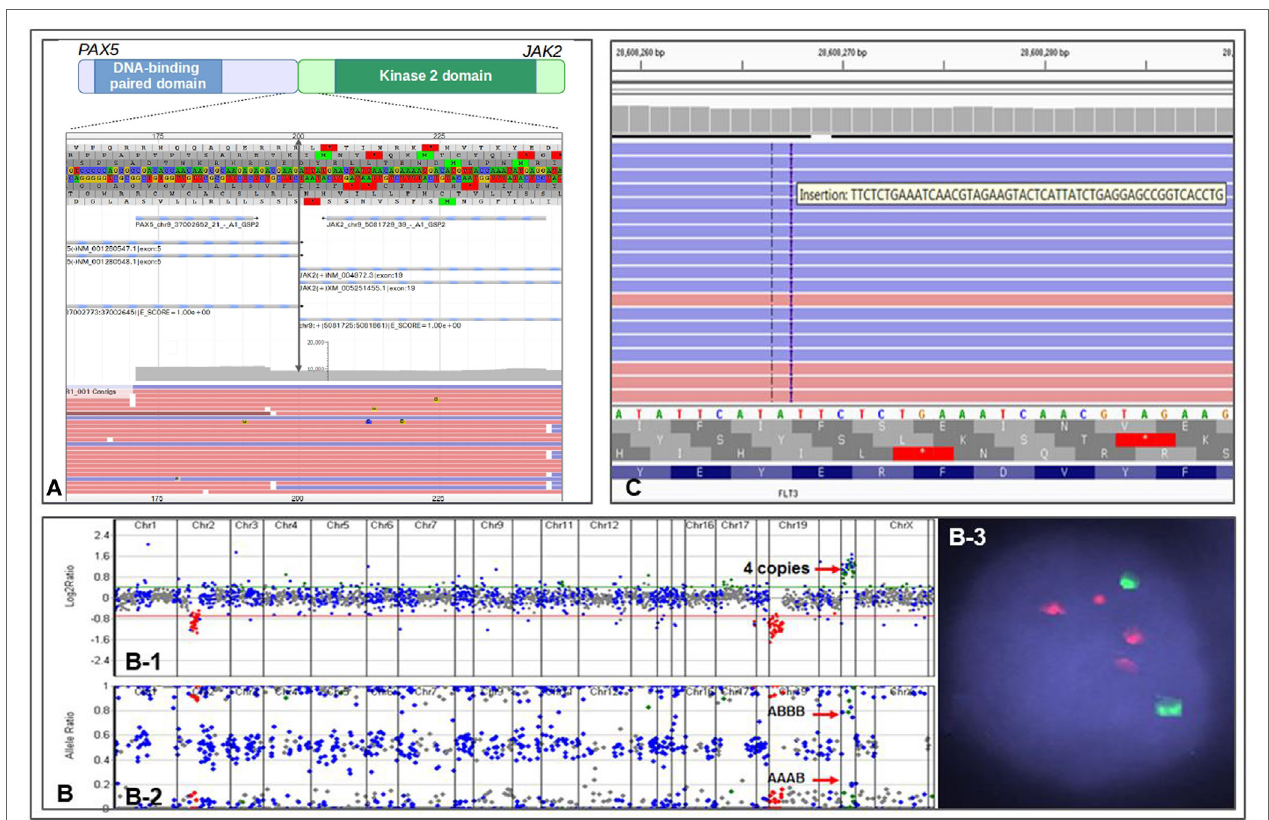
FiGUre 1 | Representations of different genomic alterations identified by CHOP Comprehensive Hematological Cancer Panel. (A) a PAX2–JAK2 fusion detected in an 11-month-old patient with residual/recurrent B-cell lymphoblastic leukemia. Double arrowed line indicates exon 5 of PAX2 is fused to exon 19 of JAK2, gray area indicates reading depth, red and blue horizontal bars are representative reads. (b) Copy number analysis using next-generation sequencing data from a patient with iAMP ALL. (B-1) Copy number variations analysis based on reading depth; red arrow indicates four copies of RUNX1 genomic region. (B-2) B-allele frequency analysis demonstrating SNP separation due to triplication of one allele; red arrows indicate genotype information of AAAB and ABBB (the genotype would be AABB if it were duplication of both allele). (B-3) FISH showing two ETV6 signals (green) and 4 RUNX1 signals (red). (c) IGV view showing a FLT3 ITD in an 11-year-old patient with acute myeloid